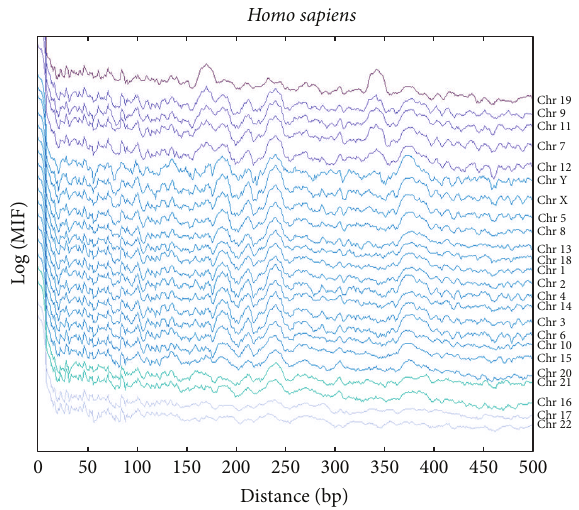
Figure 3: The MIF profiles of the decamer YYYYYRRRRR in all Homo sapiens chromosomes.